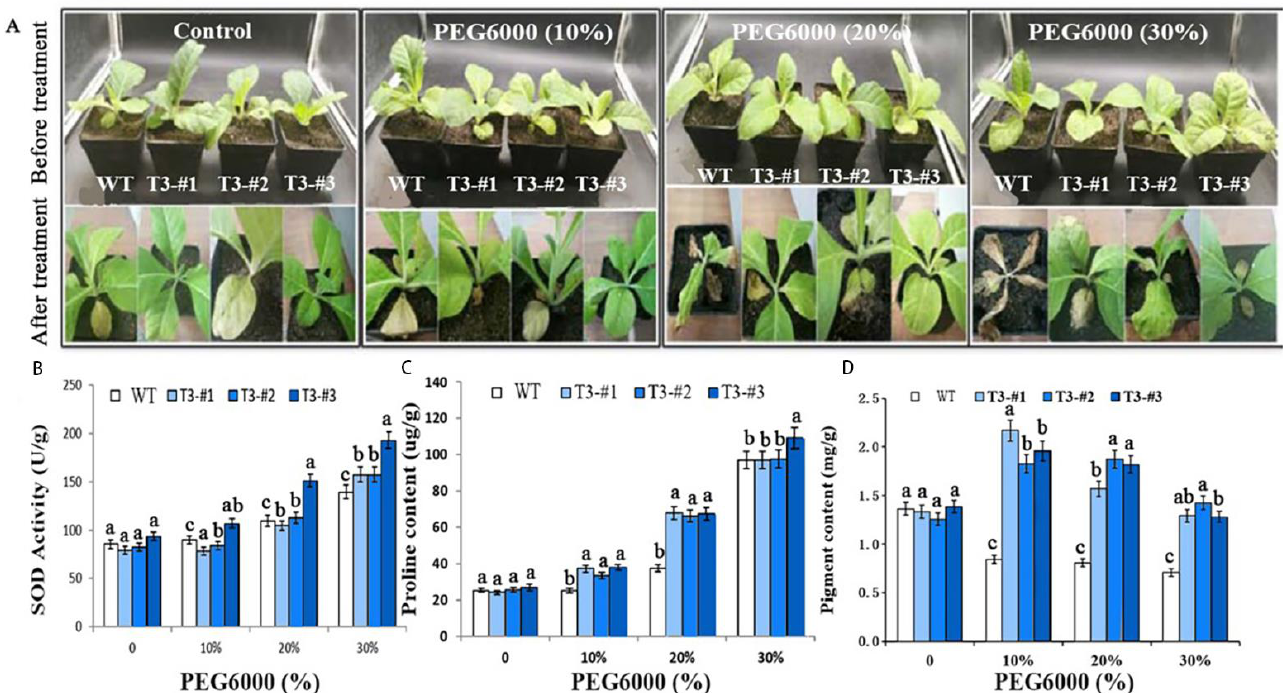
Figure 8. Enhanced drought tolerance in N. tabacum overexpressing AmPAL . ( A ) Plant phenotypes. The upper and lower panels indicated plants before and after treatment, respectively. One control and three PEG6000 treatment groups (10%, 20%, and 30%, respectively) were included. For each group, one WT and three transgenic plants (#1–3) were shown. ( B – D ): quantification of SOD, proline, and chlorophyll, respectively. Marking: The letters on the bar chart are marked for significance analysis. Where there is one same marking letter, the difference is not significant; where there is different marking letters, the difference is significant. The more different letters are, the more significant they are.